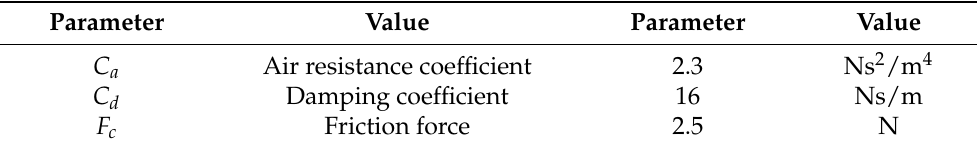
Table 3. Trampoline dynamic parameters.